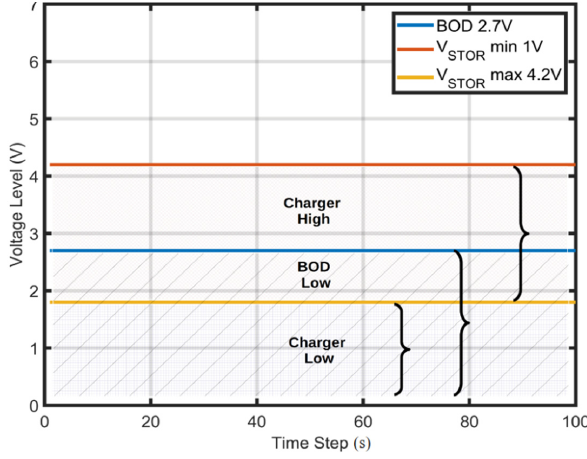
Figure 17. The BOD voltage level versus the charger voltage levels.